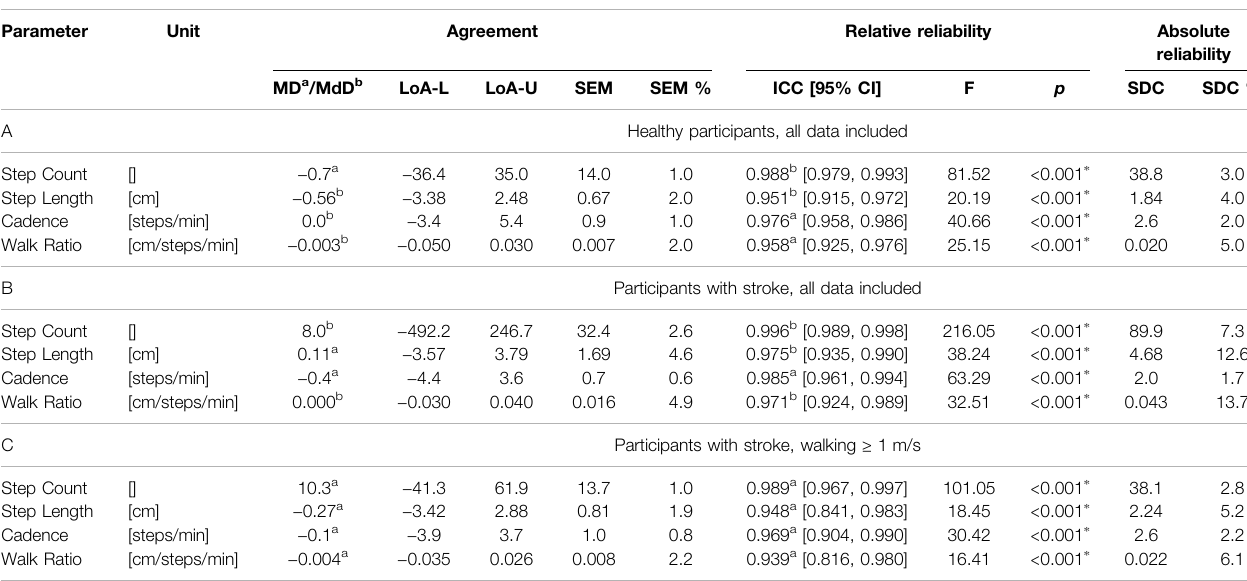
TABLE 2 | Test-retest agreement & reliability.